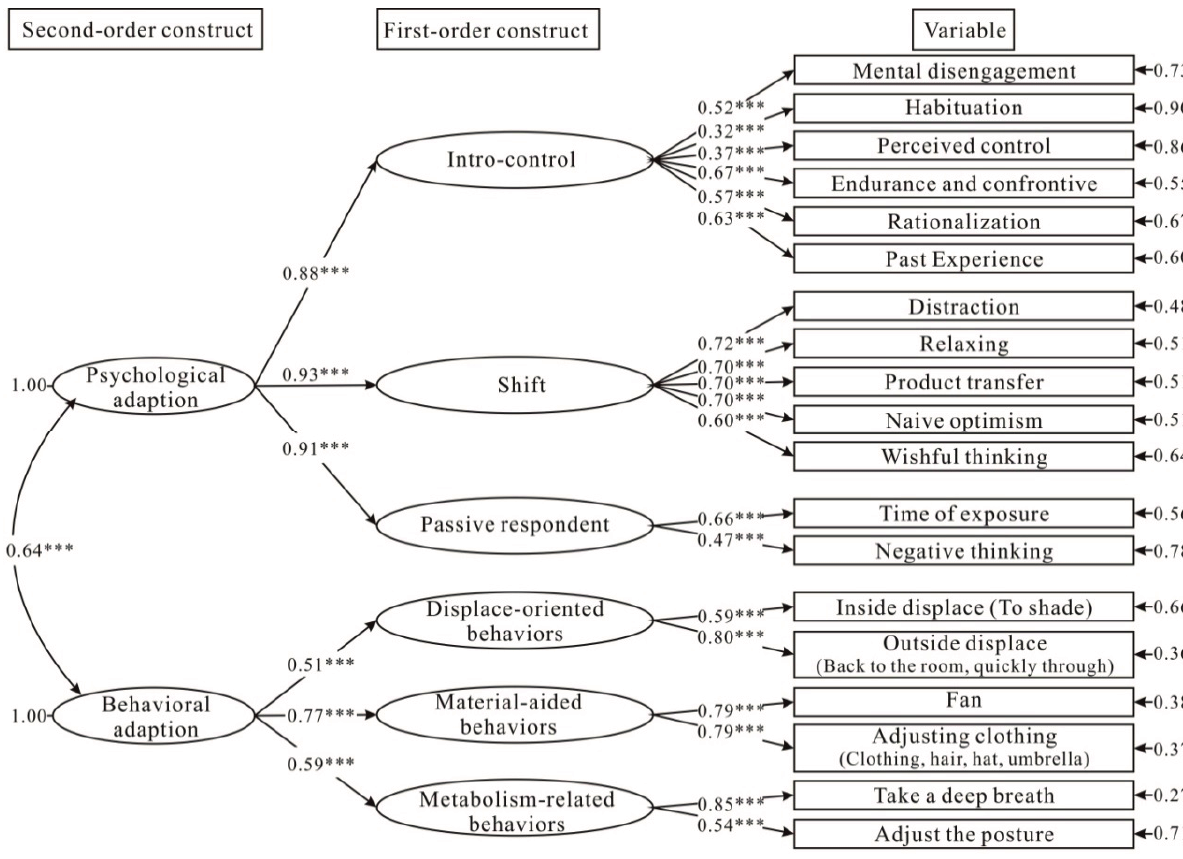
Figure A1. Modified confirmatory factor analysis of urban plaza thermal adaptation. Conflicts of